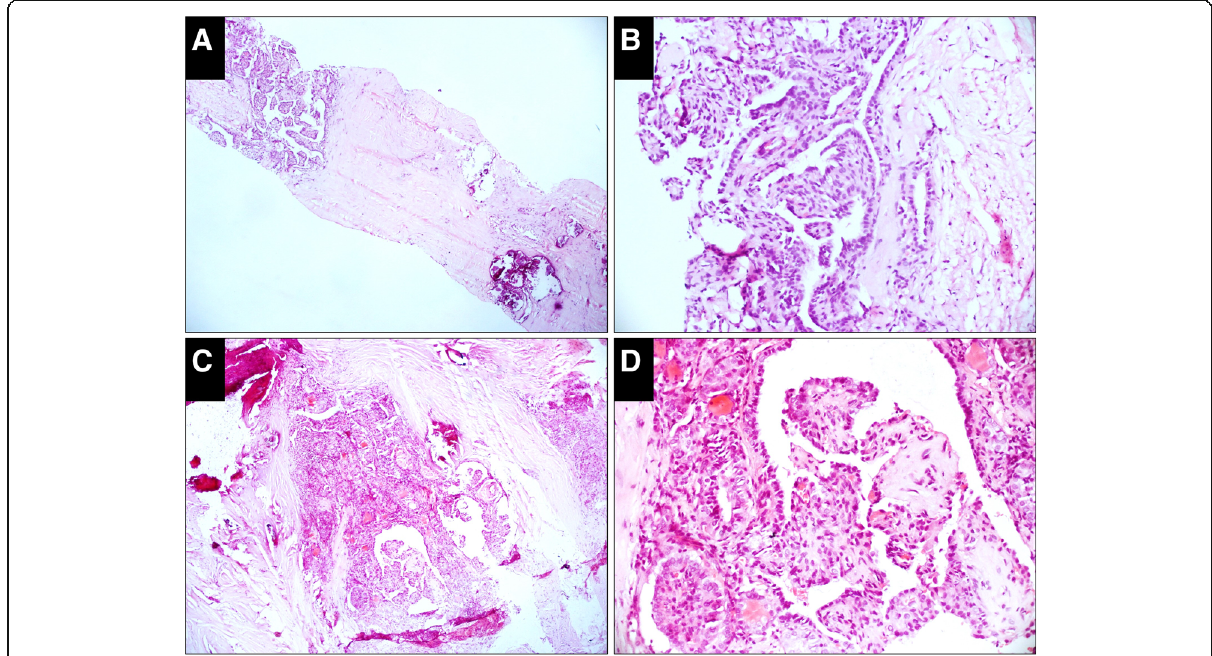
Fig. 6 Case classified as malignant in both the CNB and resected specimens (H&E). a , Papillary pattern with calcification is embedded in the hyalinized collagen (× 50). b , High-power view of the papillae shows the cells with typical nuclear features of papillary thyroid carcinoma (× 200). c , An infiltrating tumor with stromal fibrosis is prominent in the resected specimen. The major architecture of the tumor is a papillary and elongated glandular pattern (× 50). d, High-power view of the papillae shows the cells with the nuclear features of papillary thyroid carcinoma (×